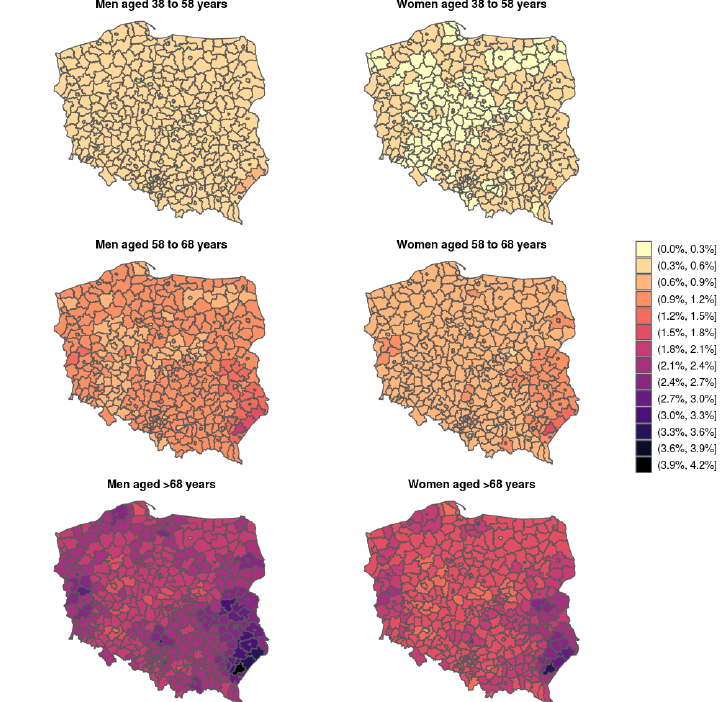
Figure 3. Estimated probability of stroke by gender and age group based on the LOGIT SPATIAL model assuming that drugs for the cardiovascular system (ATC C) have been